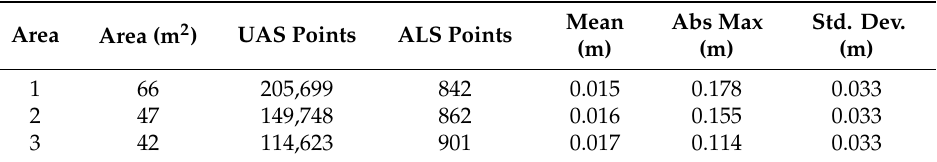
Table 7. UAS vs. ALS for small general areas without vegetation—results.